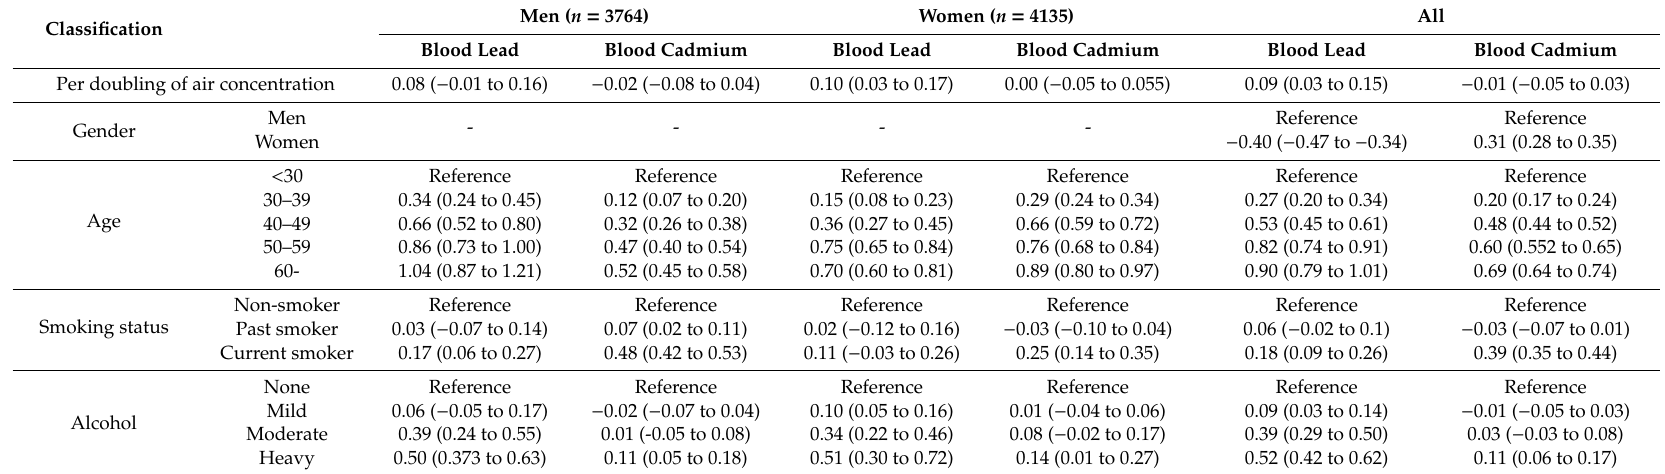
Table 4. Di ff erences (95 % CI) in blood lead and cadmium by air concentration of each metal and several classification variables after covariate adjustment# in a subgroup of the metropolitan city population in men and women (KNHANES 2008-2017) ( n =